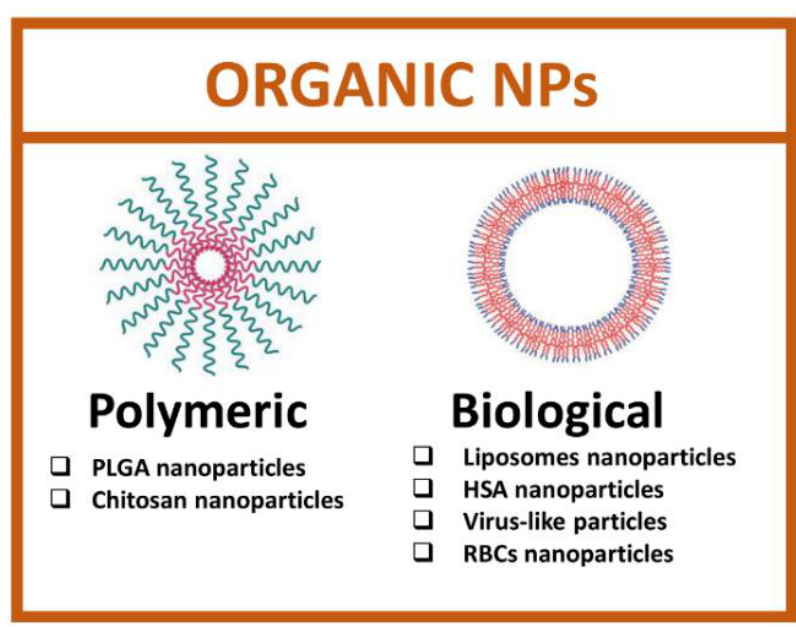
Figure 4. Types of organic nanoparticles. (Created with BioRender.com, accessed on 17 July 2022).